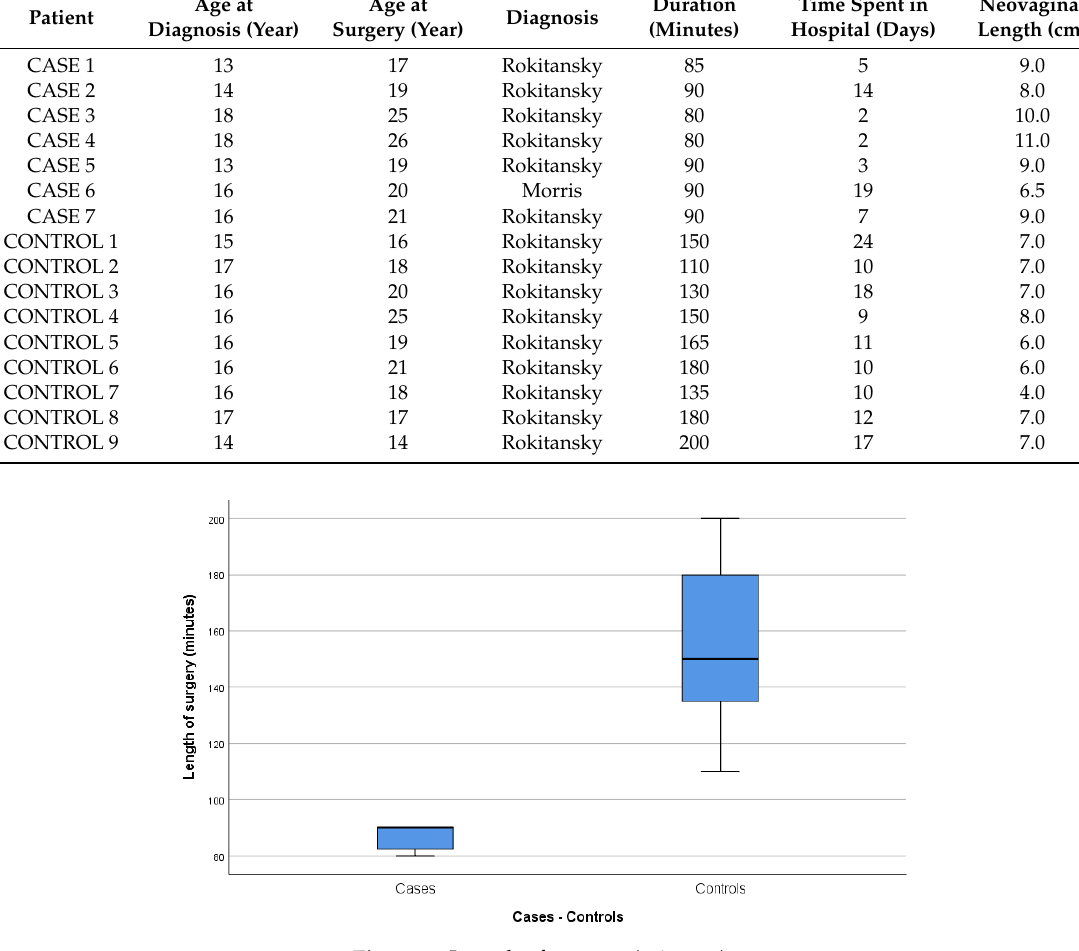
Figure 1. Length of surgery (minutes).